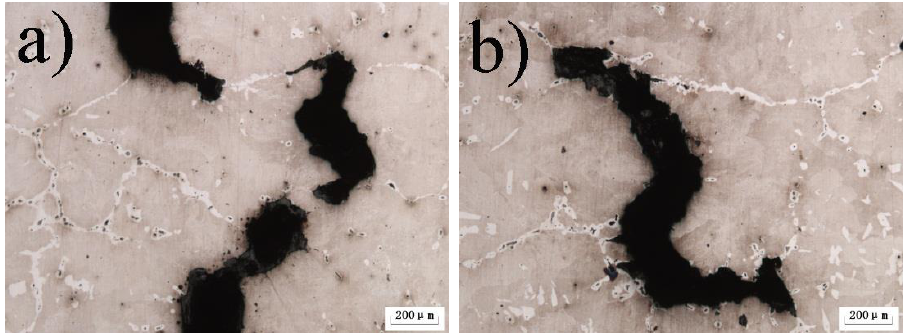
Figure 5. Morphology of central crack at etching print (( a ) typical fracture crack a; ( b ) typical fracture crack b).